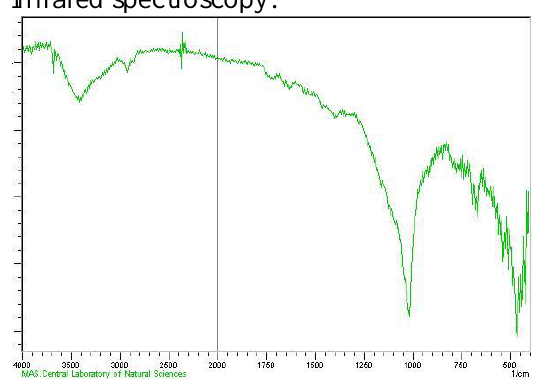
Fig 1. IR spectrum of MWCNT before the chemical treatment